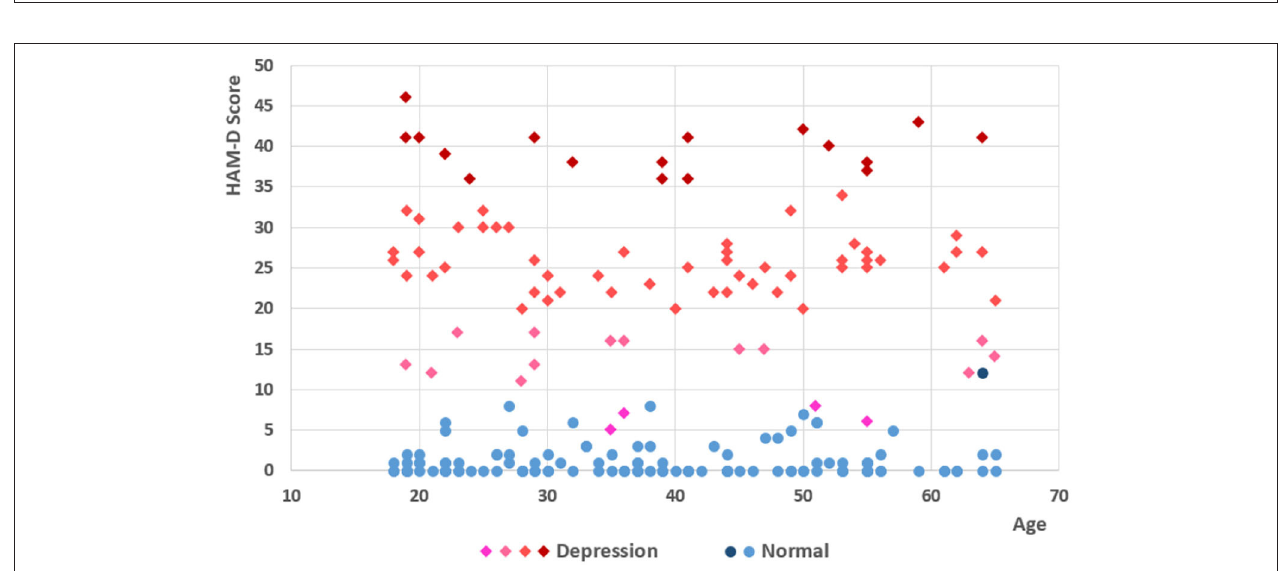
FIGURE 2 | Score and age of participants. There are 85 patients with depression and 125 normal participants in the experiment. Following the scales of HDRS-24, participants were divided into four different depressed levels, not depressed (0–8), probable (8–20), mid depressed (20–35), and very severe ( > 35), which includes 16 severe, 50 medium, and 14 probable (13 patients and 1 normal participant) and 130 non-depression (4 patients and 126 normal participants).